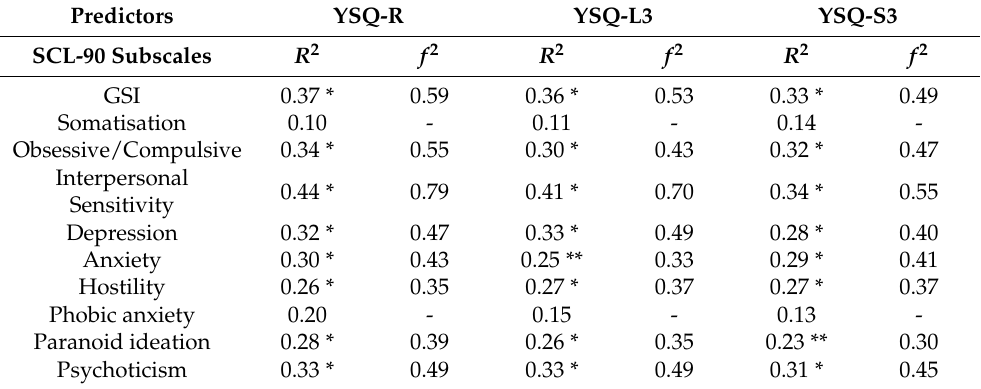
Table 4. Regression Analysis for Schema Change and Symptom Change for Each YSQ Version and SCL-90 Subscales in the Schema